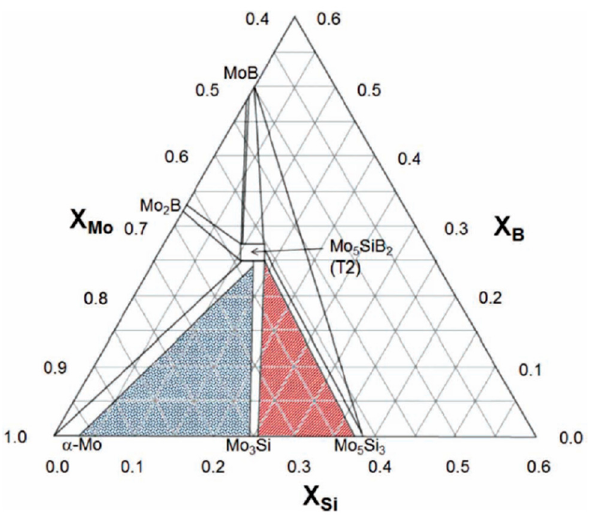
Figure 1. Diagram showing the Mo-rich portion of the 1600 °C isotherm of the Mo–Si–B phase